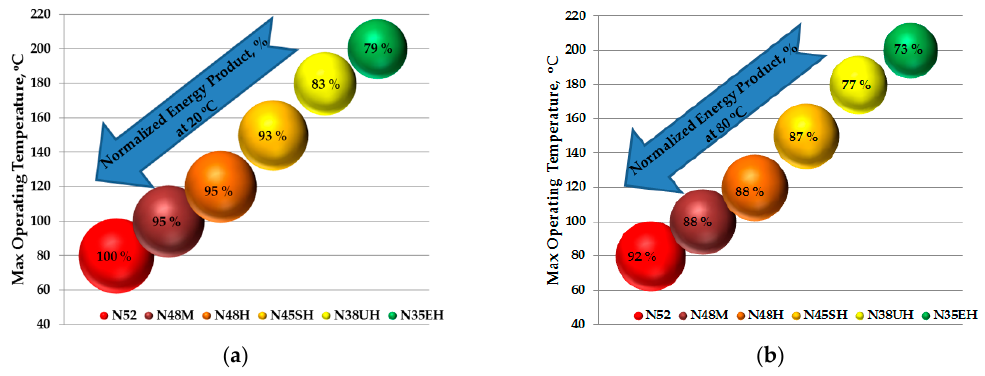
Figure 3. Normalized energy product vs. different grades of NdFeB at their corresponding maximum operating temperatures: ( a ) calculated at 20 °C; ( b ) calculated at 80 °C. Based on available information from China YY Magnetics (Zhejiang, China) [24].